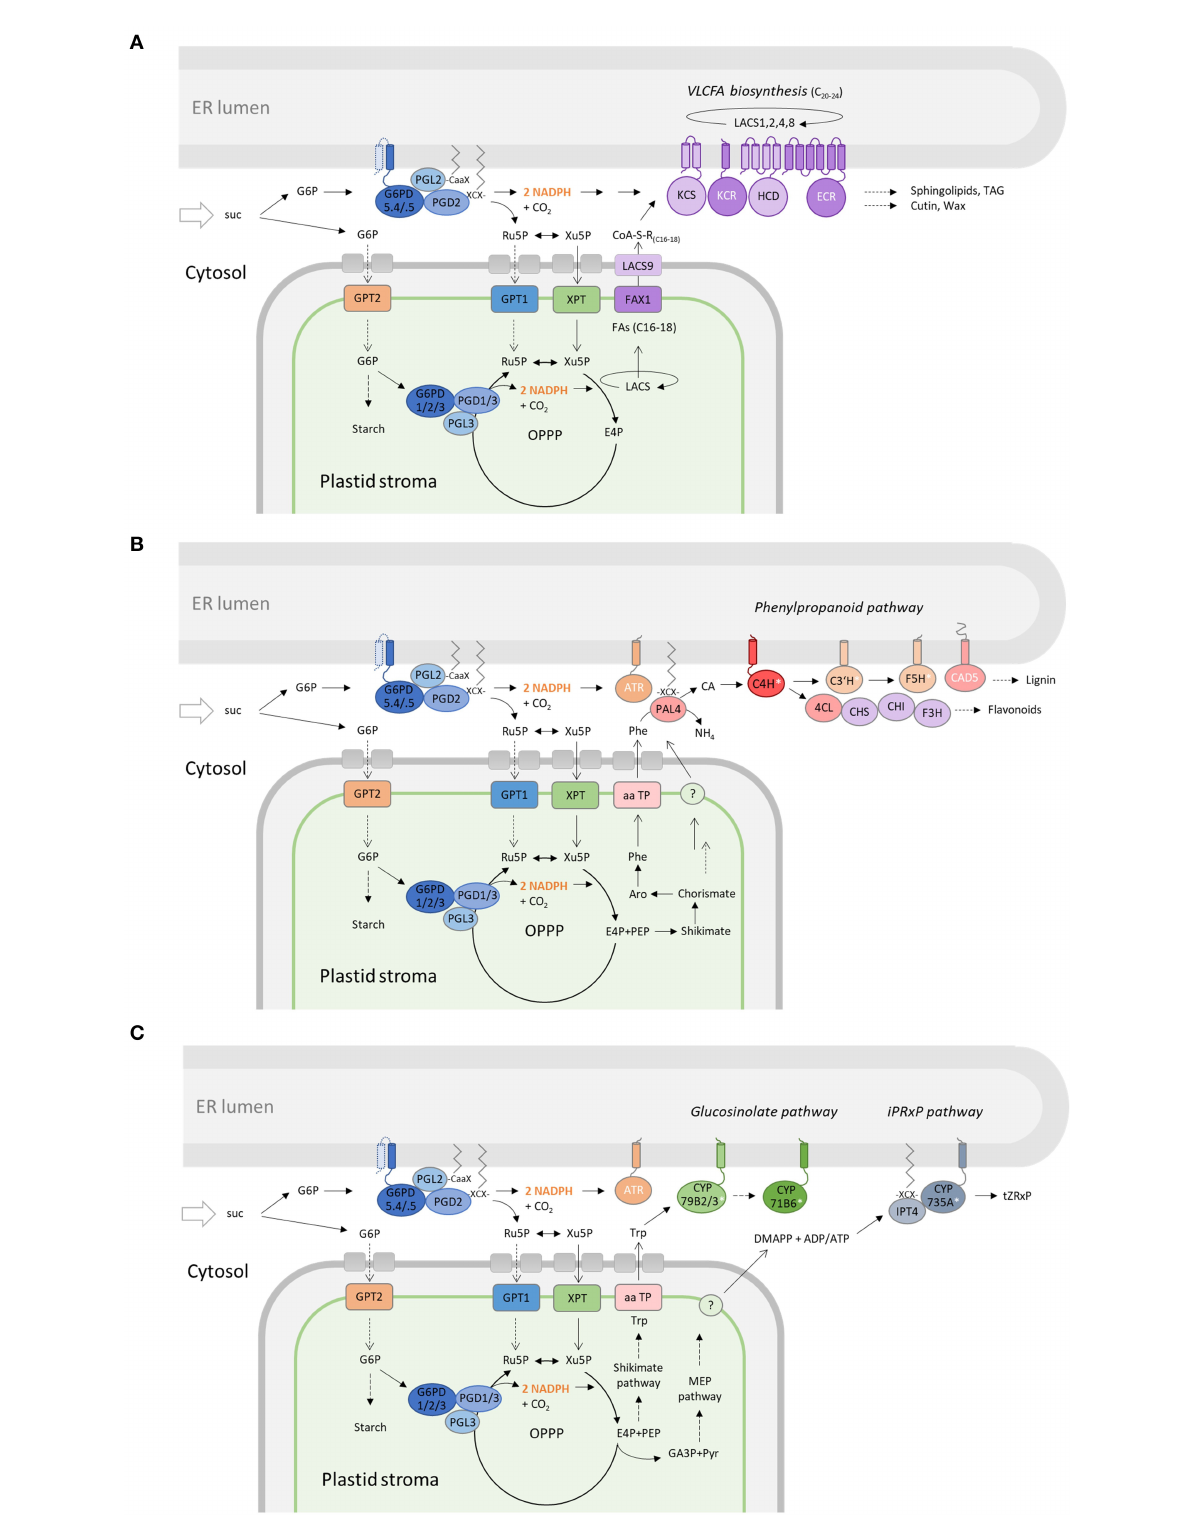
FIGURE10 Membrane-bound OPPP metabolons facilitate NADPH provision at the cytosolic face of the ER. Cooperation of the OPPP metabolon at the ER (with the complete OPPP cycle in plastids) to support membrane-bound pathways that consume NADPH in plant cells. (A) KCR1 (and ECR) are NADPH-dependent members (white) of the long-chain acyl-CoA synthase complex at the ER (LACS1,2,4,8). Chain elongation leads to very